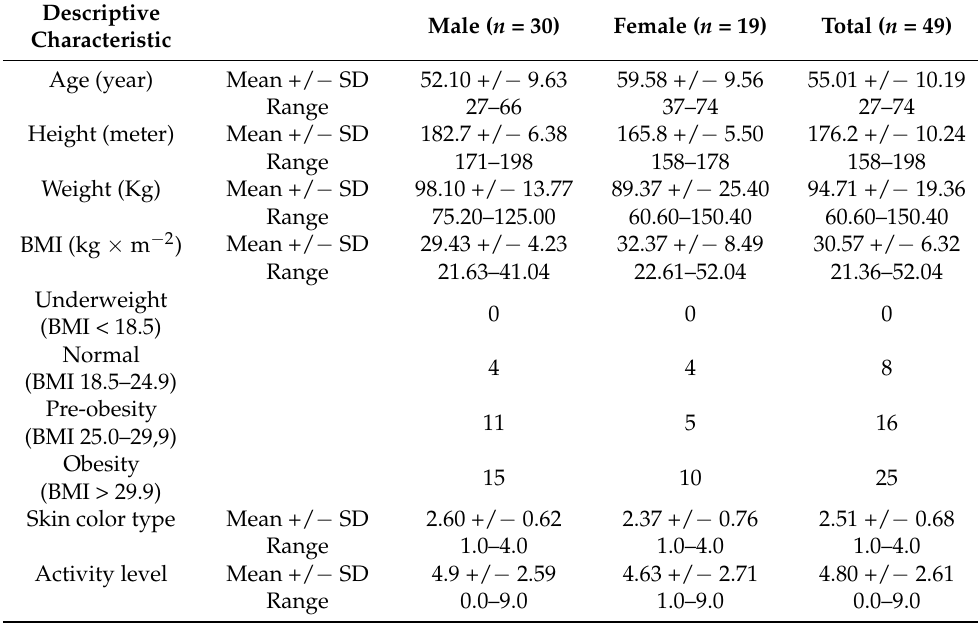
Table 1. Descriptive characteristics of participants ( n =